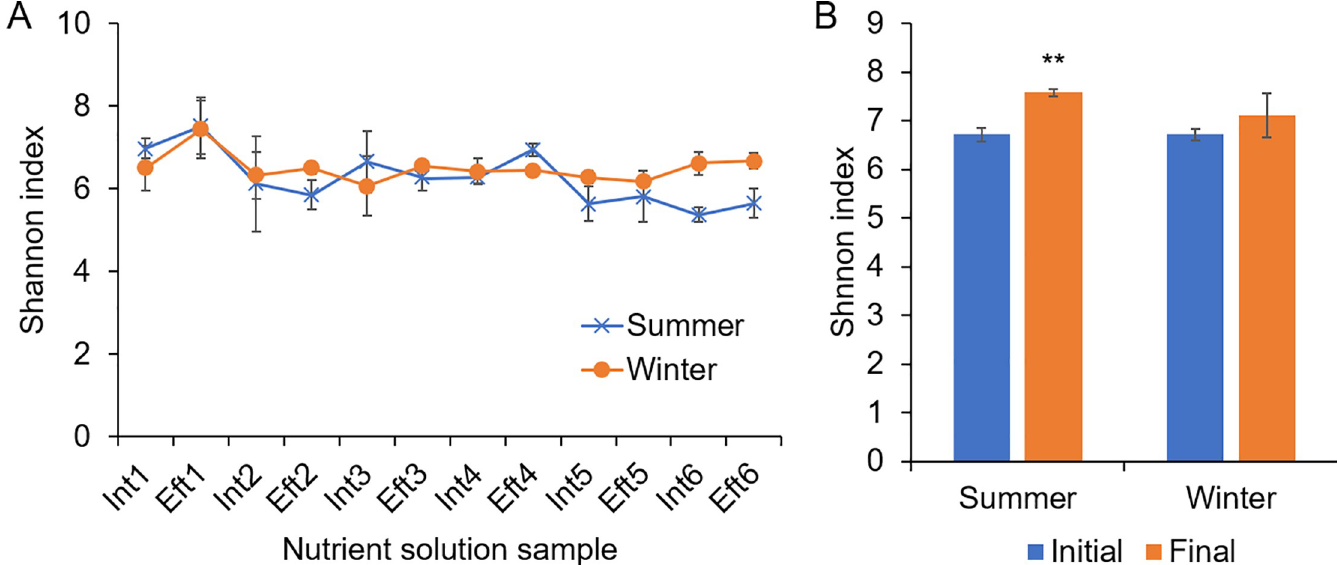
Fig 2. Dynamic changes in the Shannon index of bacterial communities in the recirculating nutrient solution (A) and substrate (B) samples from the ebb-and-flow system for cucumber plug seedling cultivation. �� , P < 0.01 compared to the corresponding initial values.